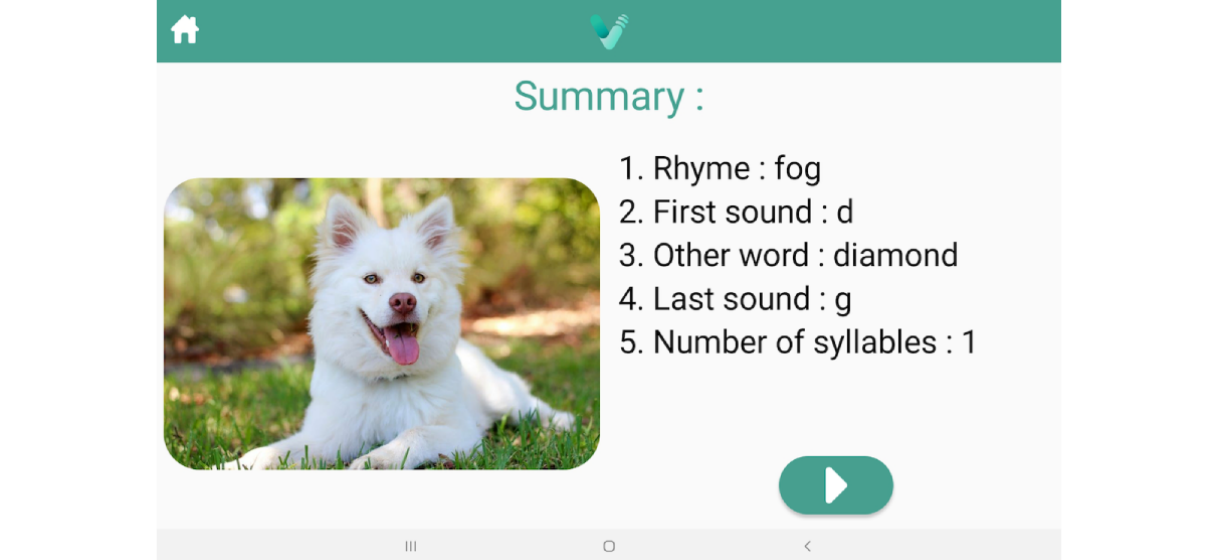
Figure 3. Screenshot from the VoiceAdapt app displaying the summary screen of the Phonological Components Analysis